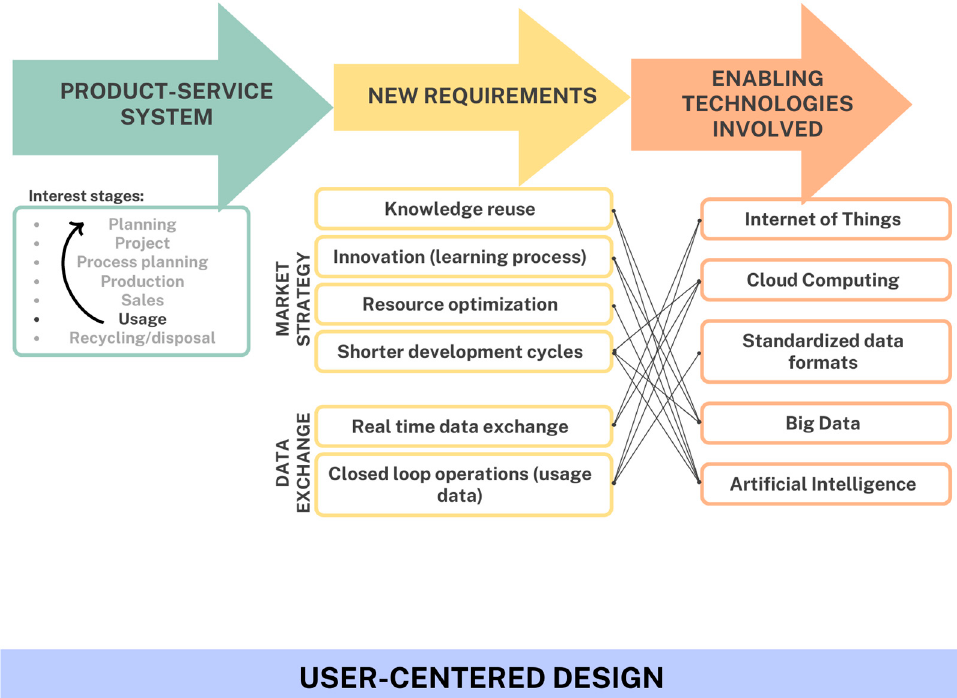
Figure 1. Product–service system framework: processes and market/organizational strategies.